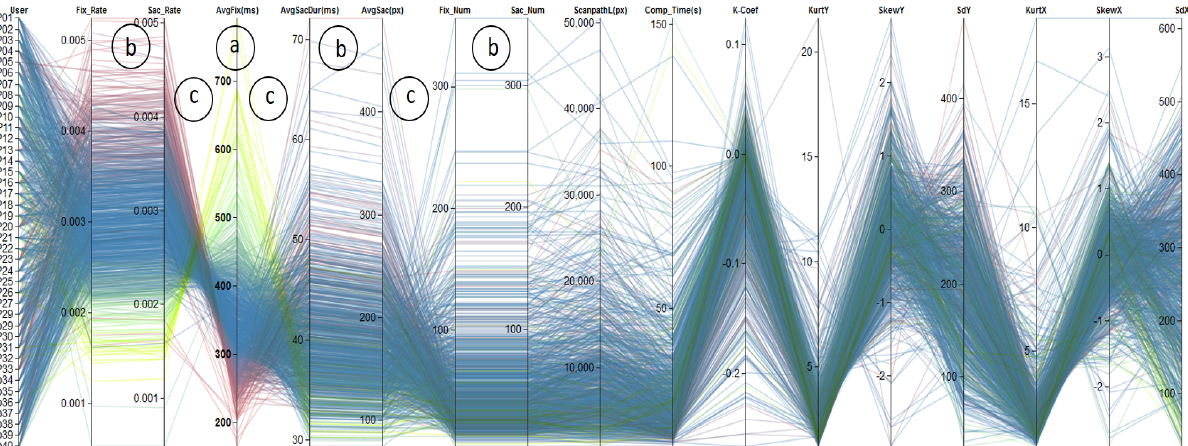
Figure 7 . Overview of all variables in a parallel coordinates diagram. Color indicates different clusters obtained from clustering based on the fourth axis ( AvgFix , (a)). The visualization also reveals positive correlation between attributes (b) and negative correlations metric, lightness L* varies to encode the similarity values for the respective metric. We assigned these colors to metrics in sub-grids in the order of the Hilbert space- filling curve, which resulted in Figure 6(d). An example